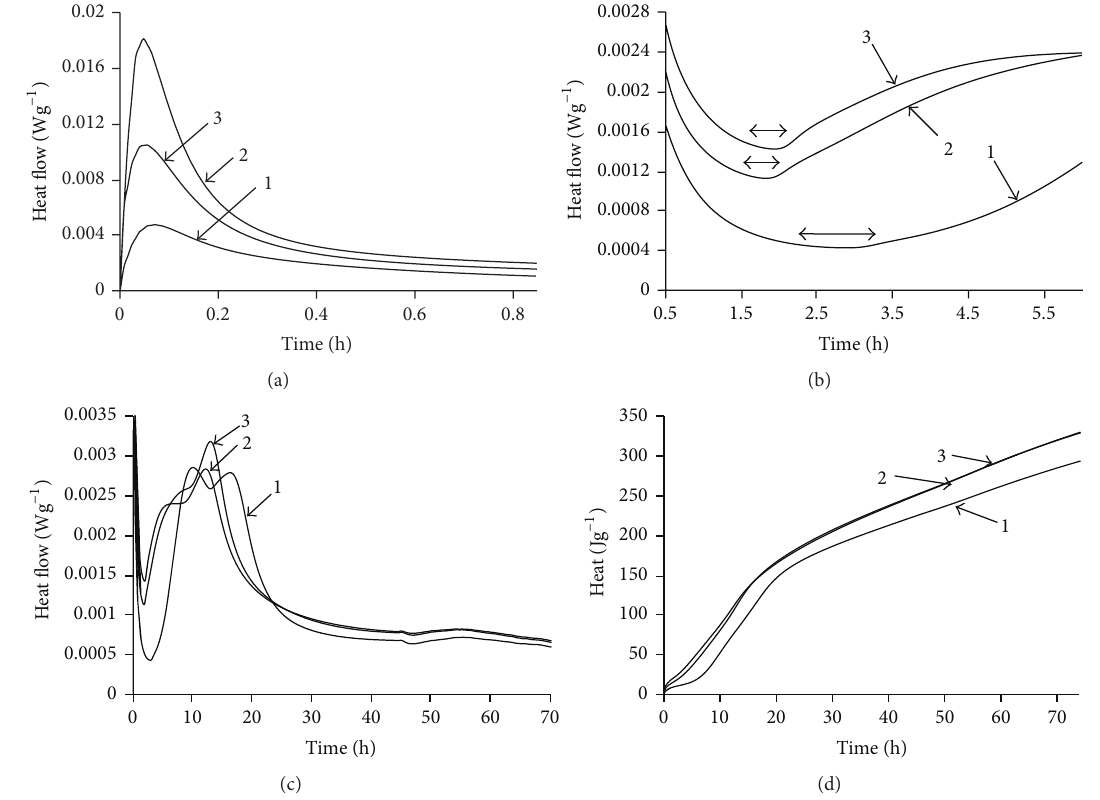
Figure 1: The heat evolution rate (a–c) and cumulative heat (d) of OPC (1), OPC-CAH1 (2), and OPC-CAH2 (3) samples during the early stage of